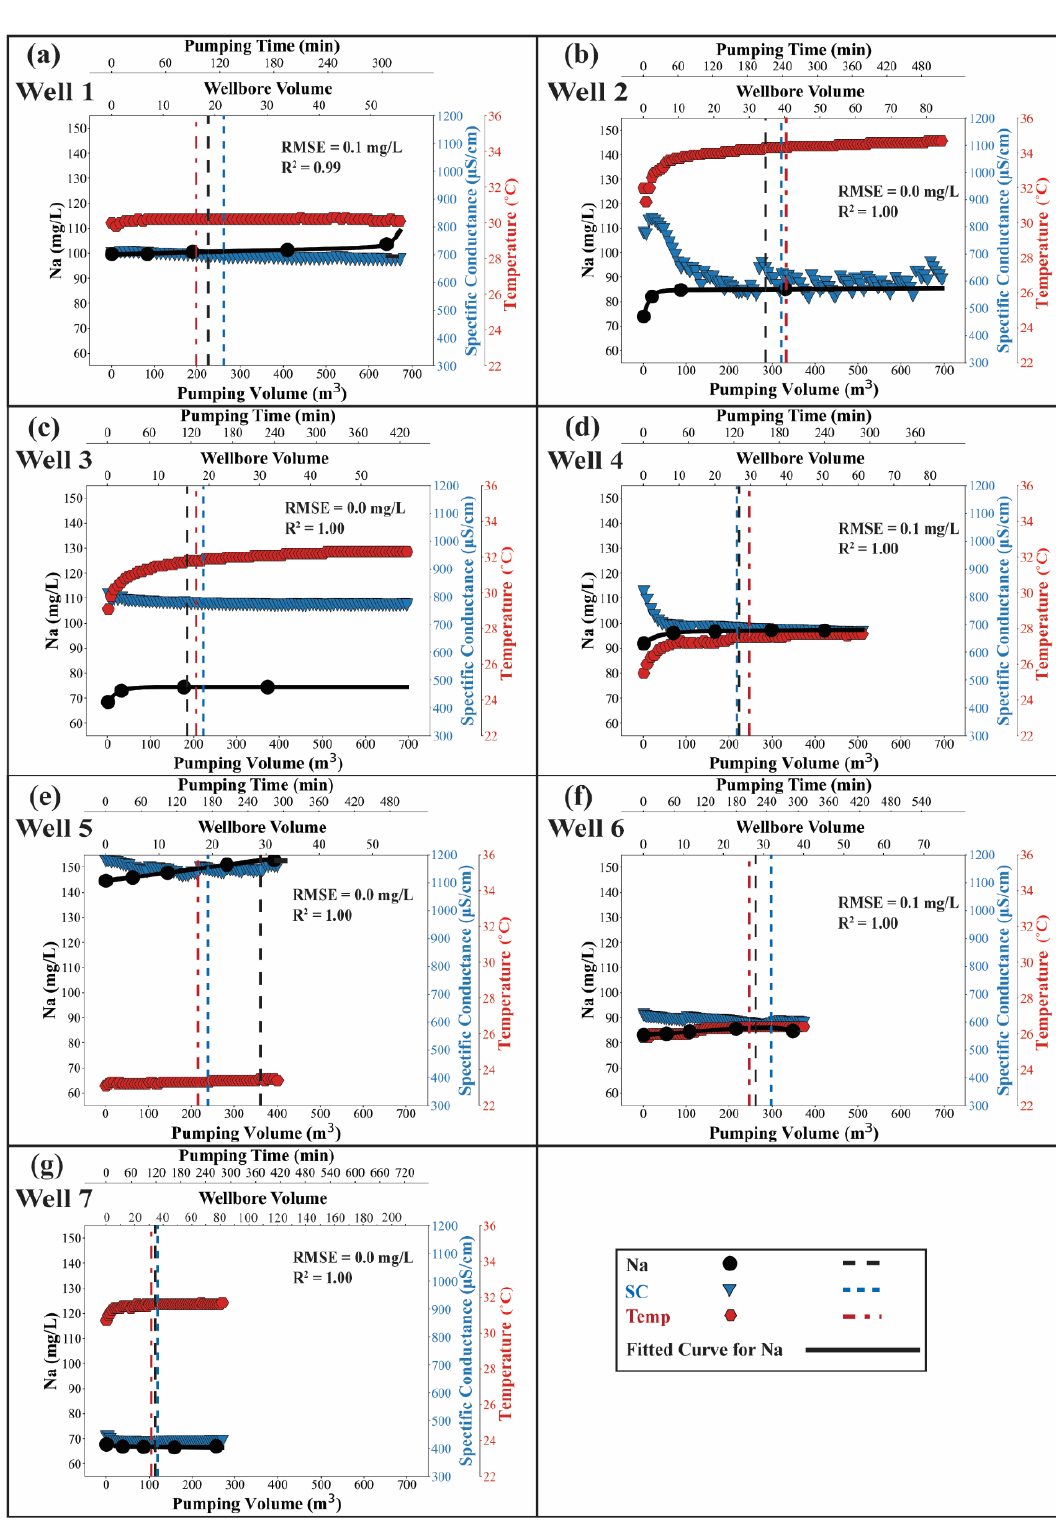
Figure 5. Variation in sodium (Na) concentration, specific conductance (SC) and temperature (Temp) in produced water from 7 time-series wells. Panels ( a – g ) represent Wells 1–7, respectively. For each well, the black solid line indicates the fitted curve for the observed Na concentration. The root mean square error (RMSE) and the coefficient of determination (R 2 ) between observed and fitted Na concentrations are presented in each panel. The black, blue and red dash lines indicate the timing that Na, SC and Temp reached steady state, respectively.